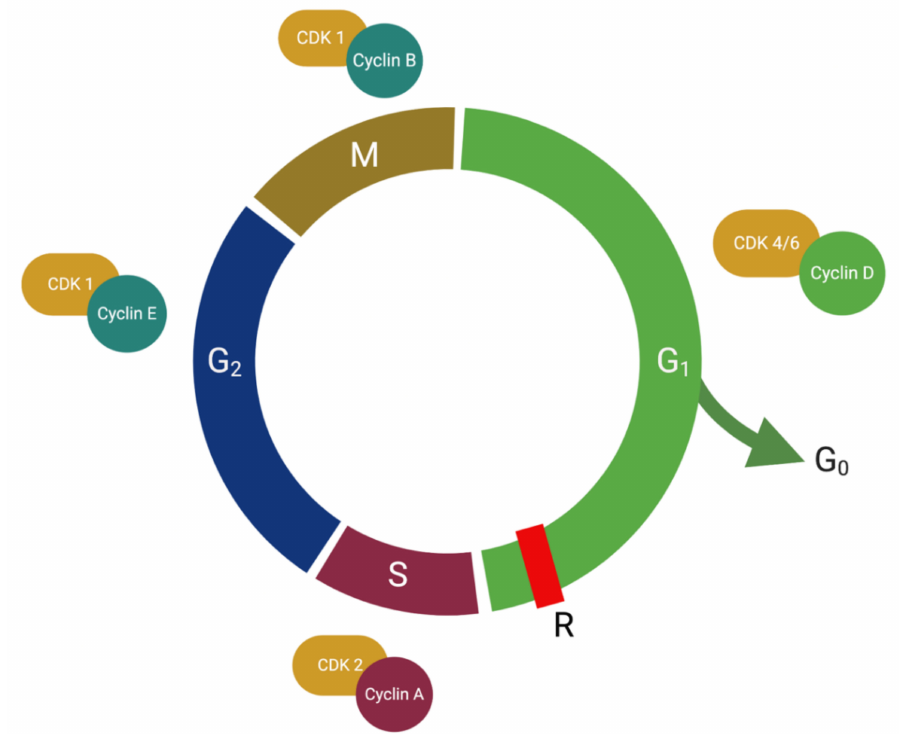
Figure 1. The cell cycle phases and key regulatory checkpoints in eukaryotes. Cells cycle through Gap1 (G1), Gap2 (G2), DNA synthesis (S), and mitosis (M) phases. Cells may temporarily exit the cell cycle at the G1 / G0 transition point in response to high cell density or mitogen deprivation. Three cell cycle checkpoints regulate sequential progression between the phases. Regulatory proteins (cyclins) pair with specific catalytic subunits (cyclin-dependent kinases) to form an active kinase that drives cell progression through the restriction point (R). (Abbreviations: G1: Gap1; G2: Gap2; S: Synthesis phase; M; Mitosis; CDK: cyclin-dependent kinase). (Source: personal